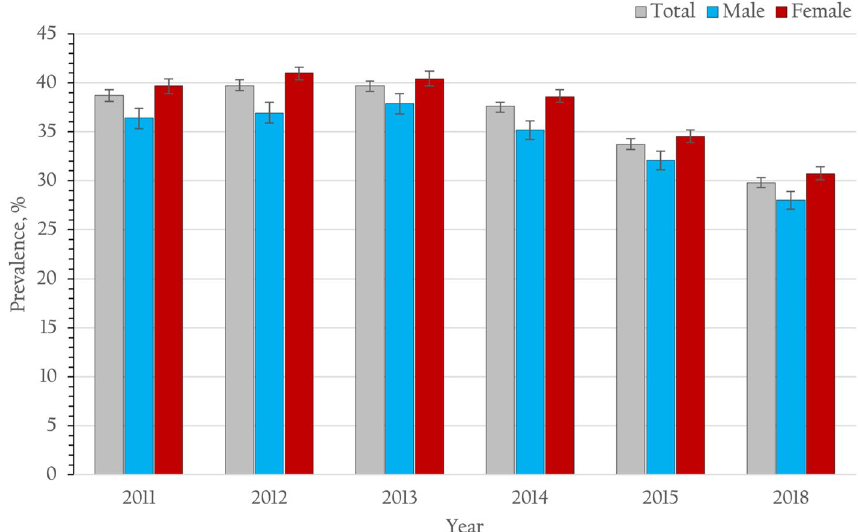
Figure 4. Prevalence of controlled blood pressure (< 130/80 mmHg) and 95% CI among patients with type 2 diabetes receiving continuous care in Thailand from 2011 to 2015 and